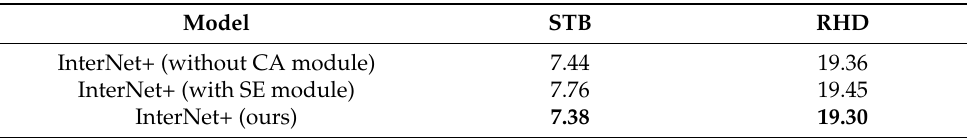
Table 6. The ablation experiment for coordinate attention mechanism module (the number of training epochs in the ablation experiment is consistent with the training state of the complete network); the evaluation is measured by EPE